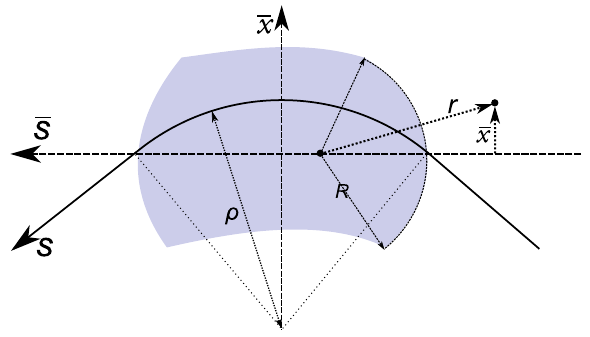
FIG. 2. Curved field boundary. R is the field boundary radius, and r is the distance from the origin to an arbitrary